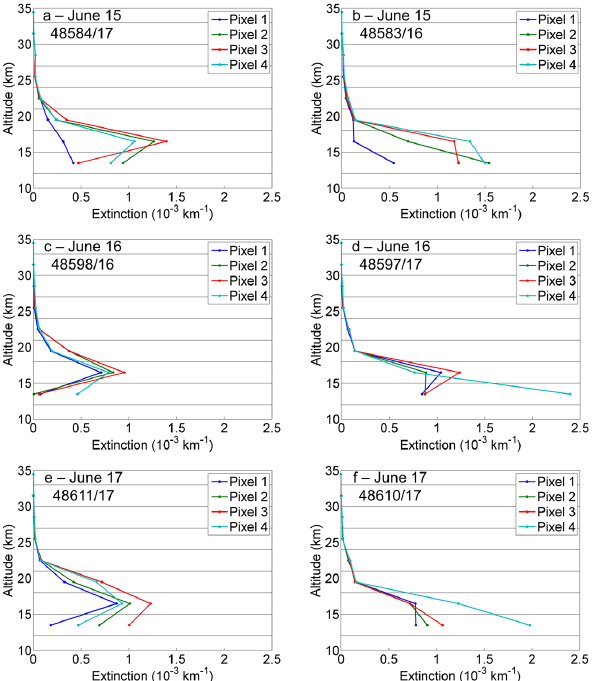
Figure 9. Limb extinction profiles of all limb pixels within the pink boxes in Fig. 8. First row (15 June): (a) orbit 48584, state 17; (b) orbit 48583, state 16. Second row (16 June): (c) orbit 48598, state 16; (d) orbit 48597, state 17. Third row (17 June): (e) orbit 48611, state 17; (f) orbit 48610, state 17. Pixel enumeration is from West to